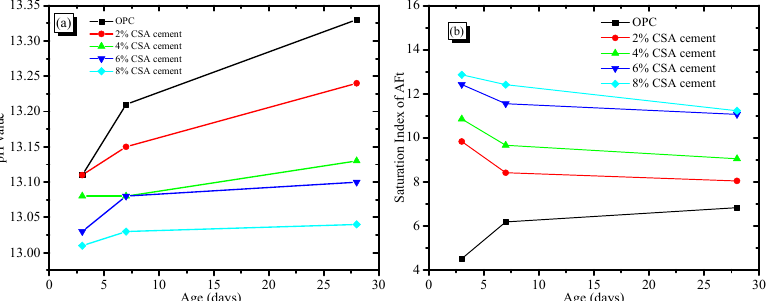
Figure 8. pH value of pore solution and saturation index of AFt in the OPC/CSA blends, ( a ) The pH value; ( b ) The saturation index of AFt.